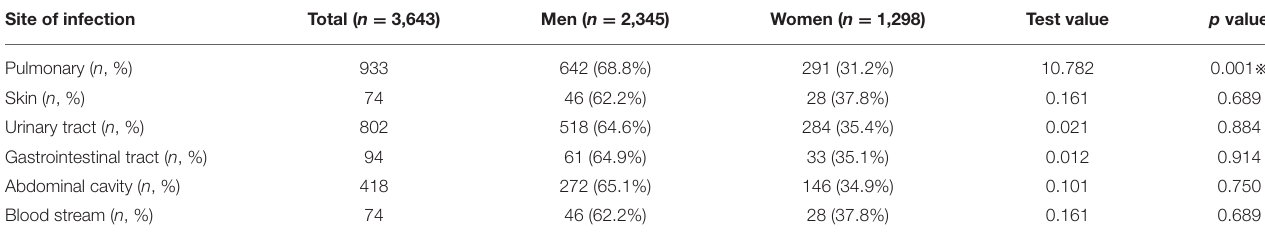
TABLE 2 | Site of infection in different genders.